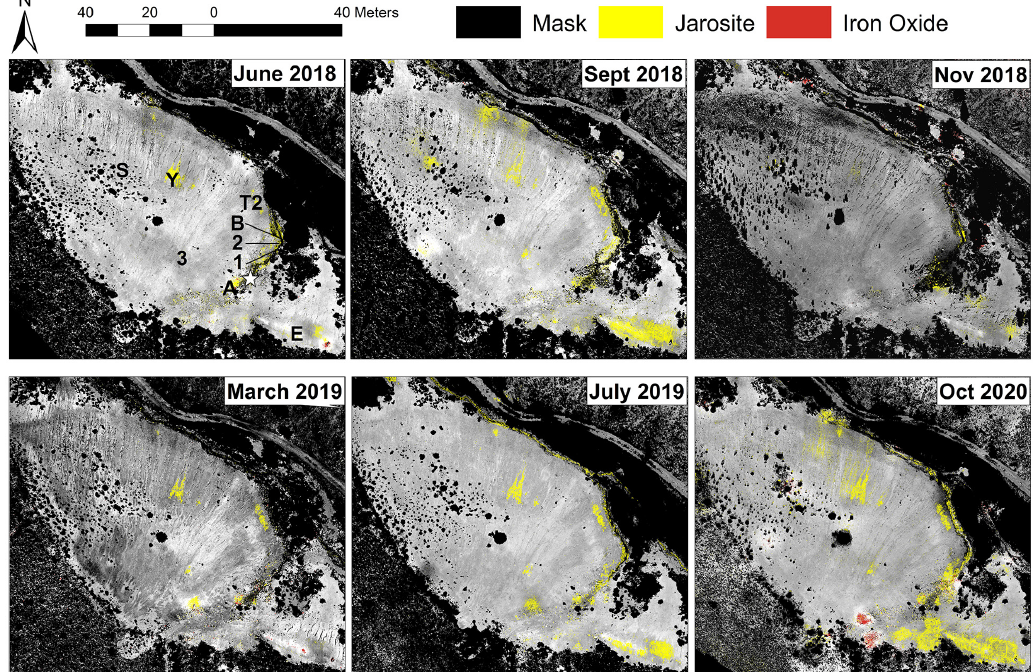
Figure 8. Results of Band Math Ratios for each remotely piloted aerial system survey. Locations for ground surveys are indicated on the June 2018 map for Y, T2, B, A, E, S, and Transects 1–3 (1,2,3), and the adit drain is indicated with a star. Each scene is 134 m wide and 118 m